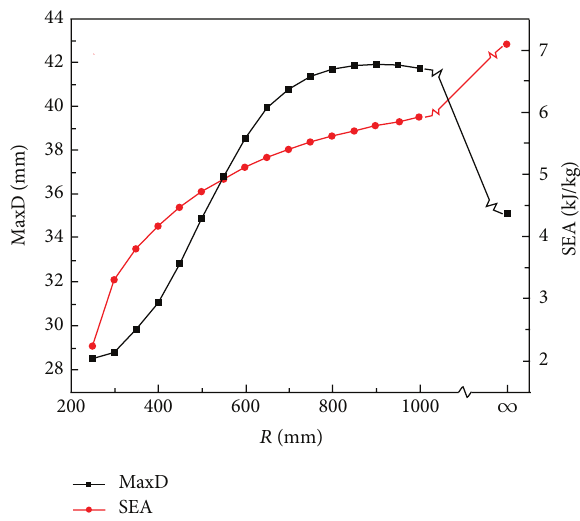
Figure 7: Effect of curvature radius on the blast-resistant indices of curved sandwich